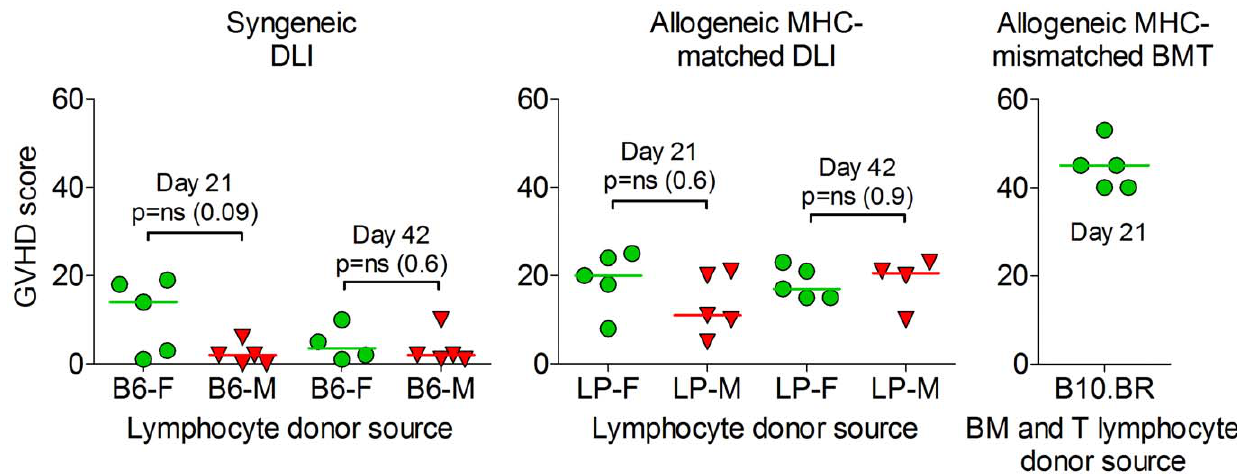
Figure 4. Adoptively transferred female lymphocytes do not produce increased graft-versus-host disease. Male B6 mice were given 6 Gy irradiation followed by an i.v. infusion of 3 6 10 7 splenocytes, either male or female, from syngeneic B6 or allogeneic LP donors. For comparison, female B6 mice were lethally irradiated (11 Gy) and transplanted with 5 6 10 6 T-cell depleted bone marrow cells and 2 6 10 6 purified splenic T cells from MHC-mismatched B10.BR mice (H2k into H2b). Mice were evaluated on the day indicated for histological evidence of GVHD in the liver, small intestine, and large intestine. Results of a single experiment.